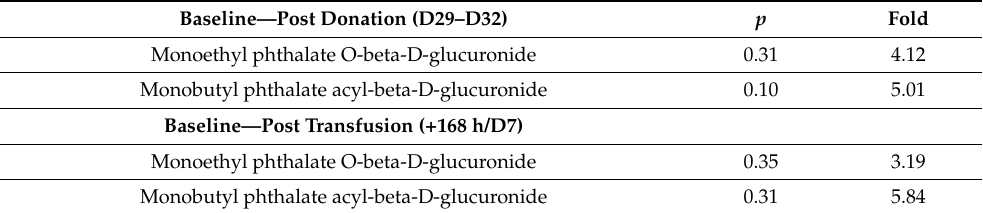
Table 1. Phthalates identified in urine in post-donation and post-Transfusion phases.